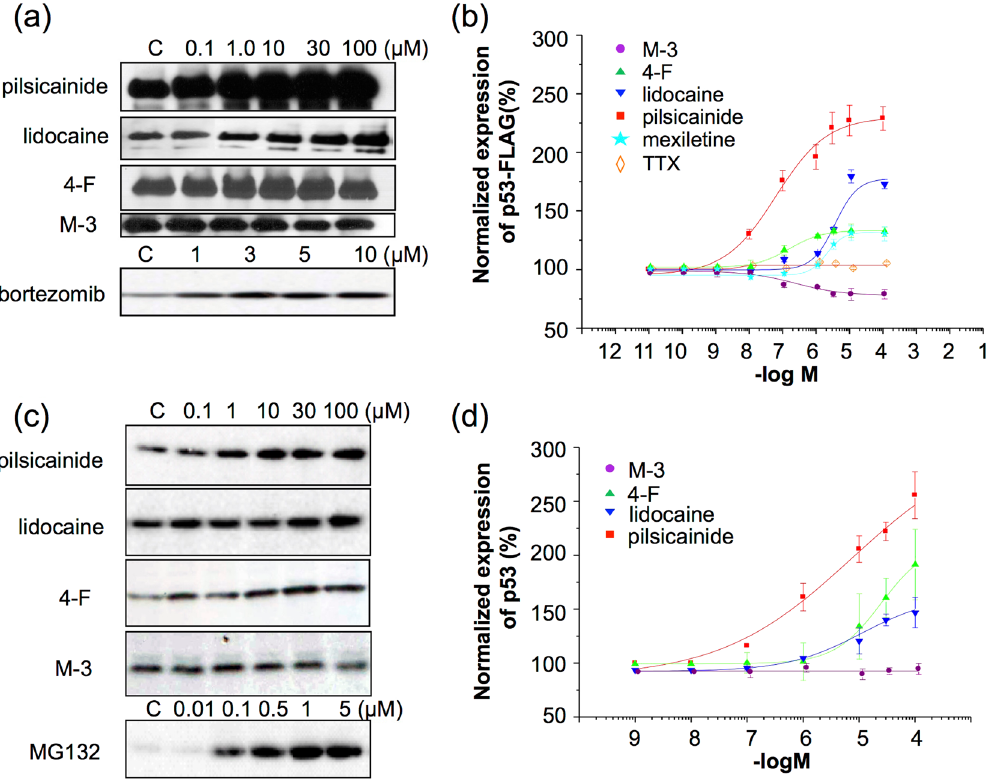
Figure 3. Pilsicainide and lidocaine increase transfected and endogenous p53. ( a ), ( b ) Dose-dependent effects of MG132 and LAs on ubiquitinated p53-FLAG protein. Cell lysates were analyzed by Western blot analysis ( a ). Quantitative analysis of p53-FLAG stability using densitometry is shown in ( b ). Each point was expressed relative to the values in the absence of drugs (100%). ( c ), ( d ) Dose-dependent effects of LAs on endogenous p53 expression in MKN45 cells. MKN45 cells were cultured for 24 h in the presence of pilsicainide, lidocaine, 4-F, M-3 or MG132. Cell lysates were analyzed by Western blot analysis ( c ). Quantitative analysis of the protein level of endogenous p53 was conducted using densitometry ( d